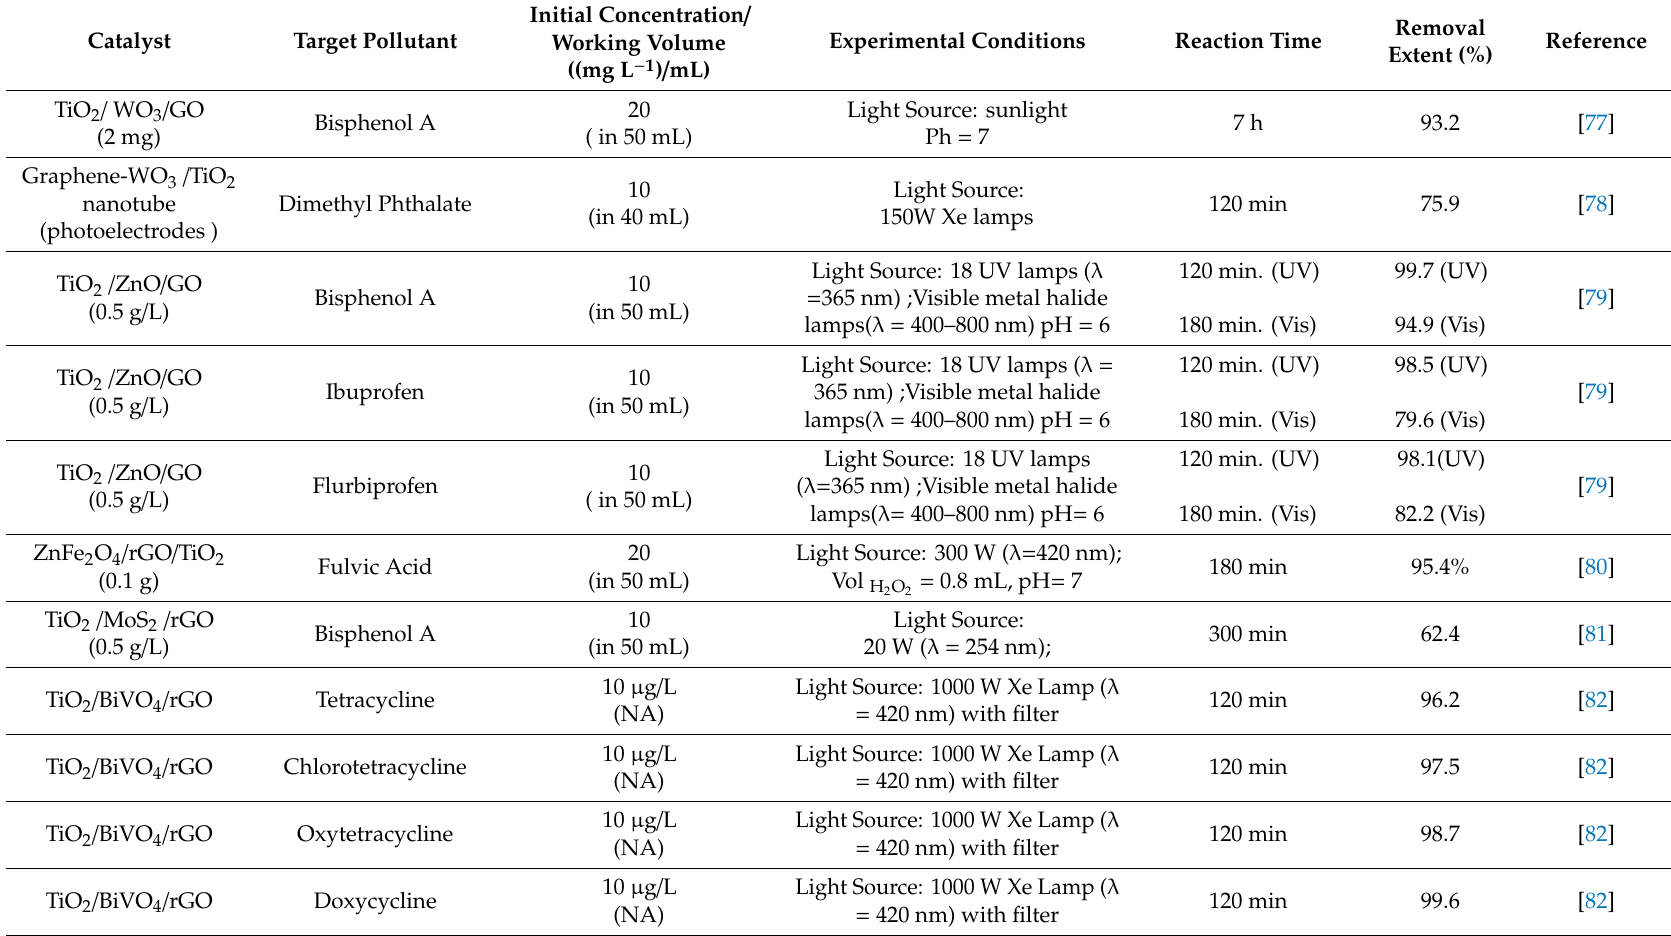
Table 8. Photocatalytic degradation of CEC’s over TiO 2 / Semiconductor / graphene